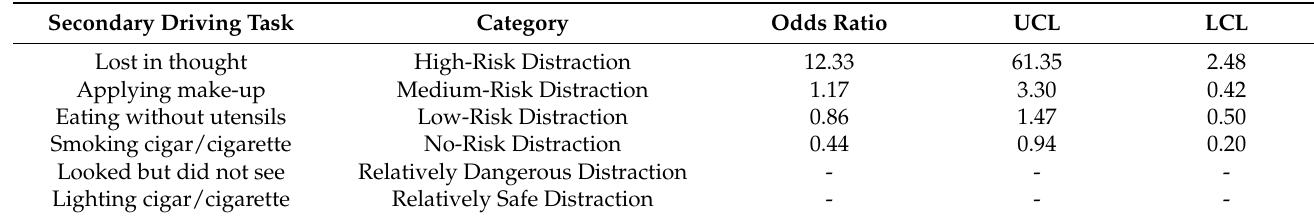
Table 6. Odds ratio calculation results of some secondary driving tasks.